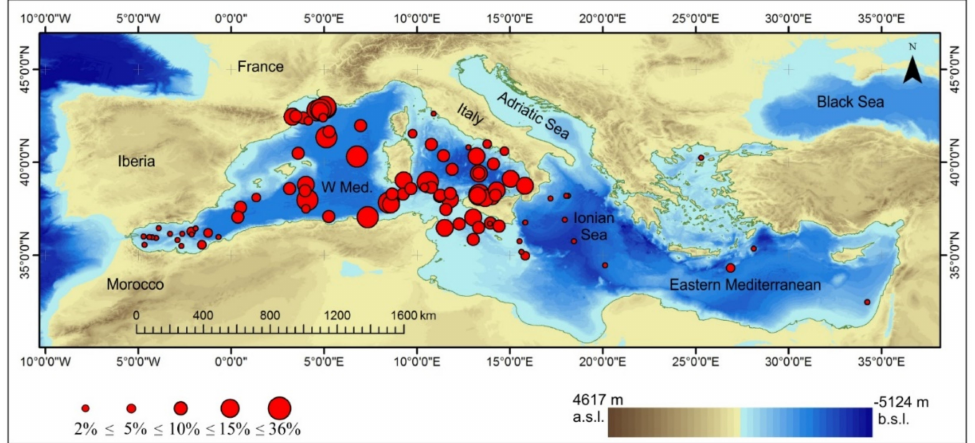
Figure 2. Map of the Mediterranean Sea with the sampling points of the study cores (yellow dia- monds). GoL = Gulf of Lion; NB = North Balearic; SB = South Balearic; ST = southern Tyrrhenian (1, 2, 3, 4); CT = central Tyrrhenian (1, 2); TS = Tyrrhenian Sea; SC = Sicily Channel; WS = west Sicily (see Table